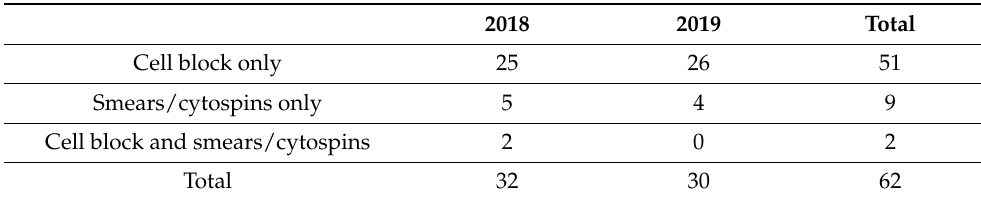
Table 1. Samples for molecular